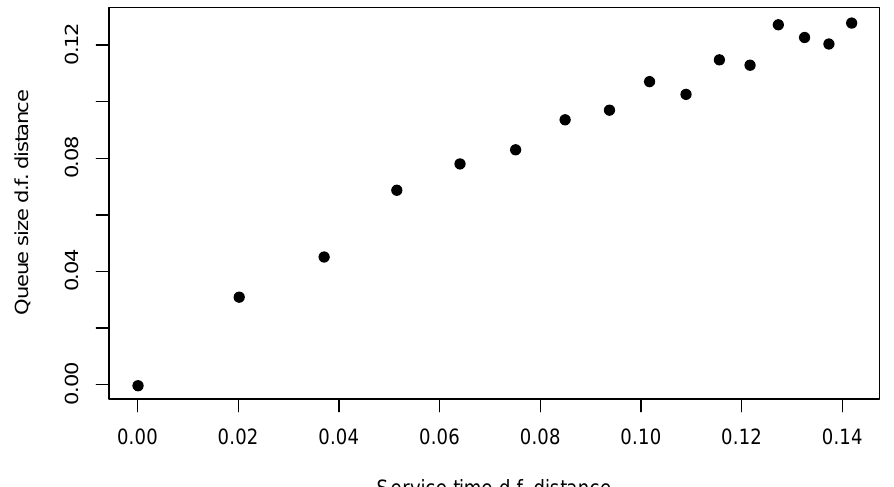
) , between the empirical queue size d.f. in a basic M / M /5 system Figure 3. Distance, ∆ ( ˆ F , ˆ F Q ( M ) Q ( 1 ) with input rate λ = 5, service rate µ 1 = 2, compared to a contaminated M / H 2 /5 system with input rate λ = 5 and hyperexponential service times being a mixture with µ 1 = 2 and µ 2 = 2,2.4, . . . ,8, p = 0.7, obtained from N = 10,000 samples, vs. service time d.f. distance, ∆ ( F M , F 1 ) .